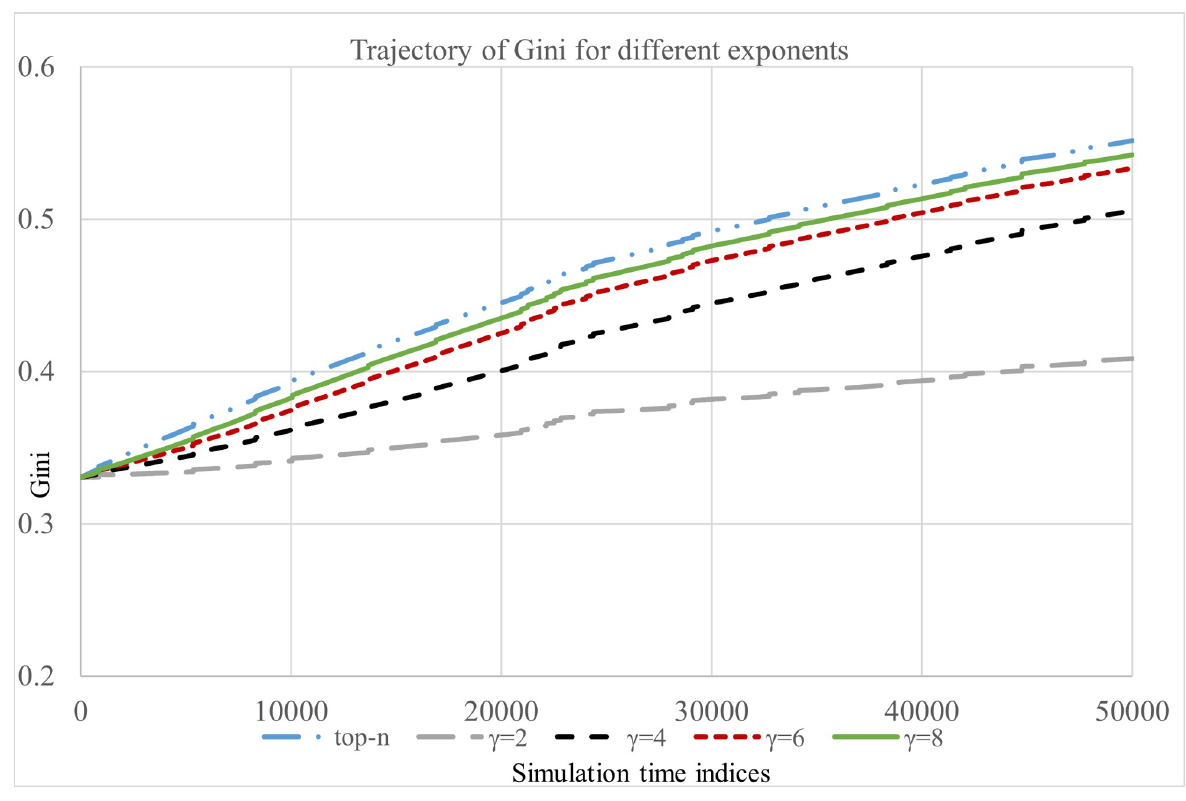
Fig 4. Inequality in popularity measured using Gini